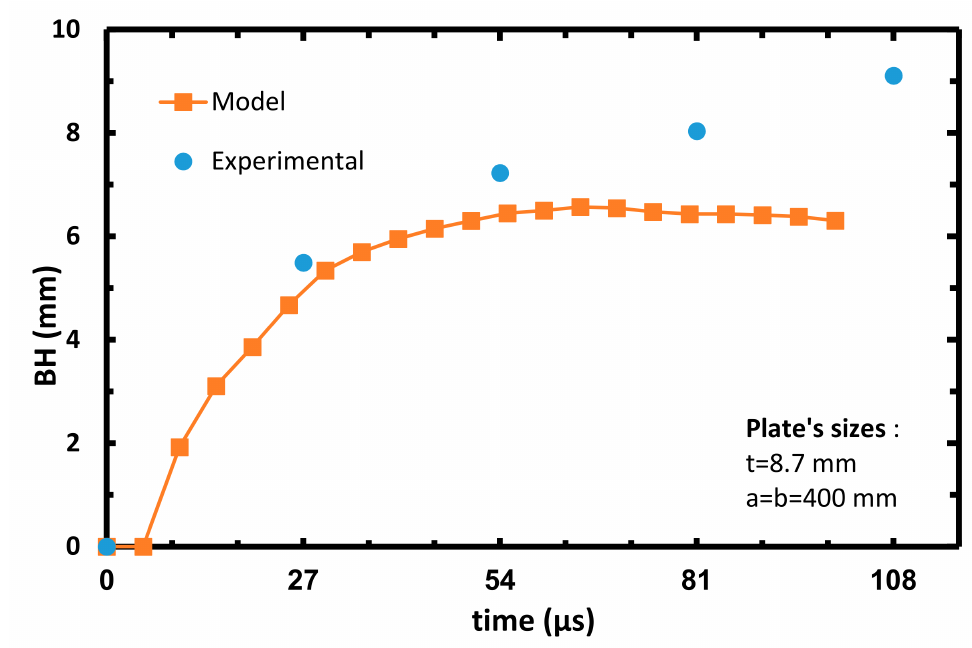
Figure 14. Plate’s bulge height vs. time of the calibrated model, Vinitial = 436 m/s.